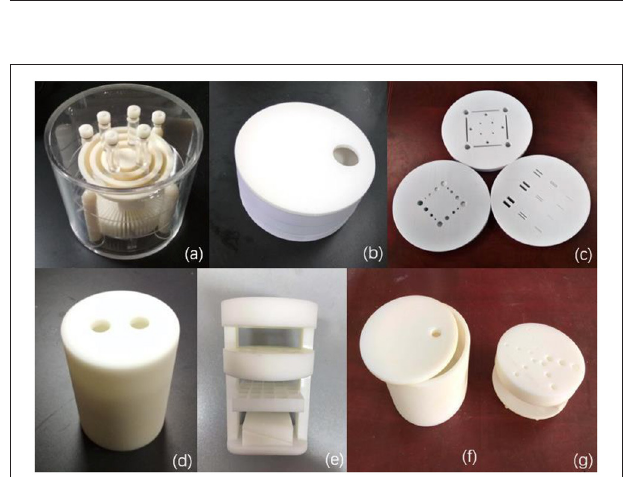
FIGURE 4 | Three-dimensional design of a phantom module. (A) Star module, (B) layer thickness module, (C) line-pair high contrast resolution module, (D) low contrast resolution modules, (E) geometric distortion module, (F) location accuracy module.